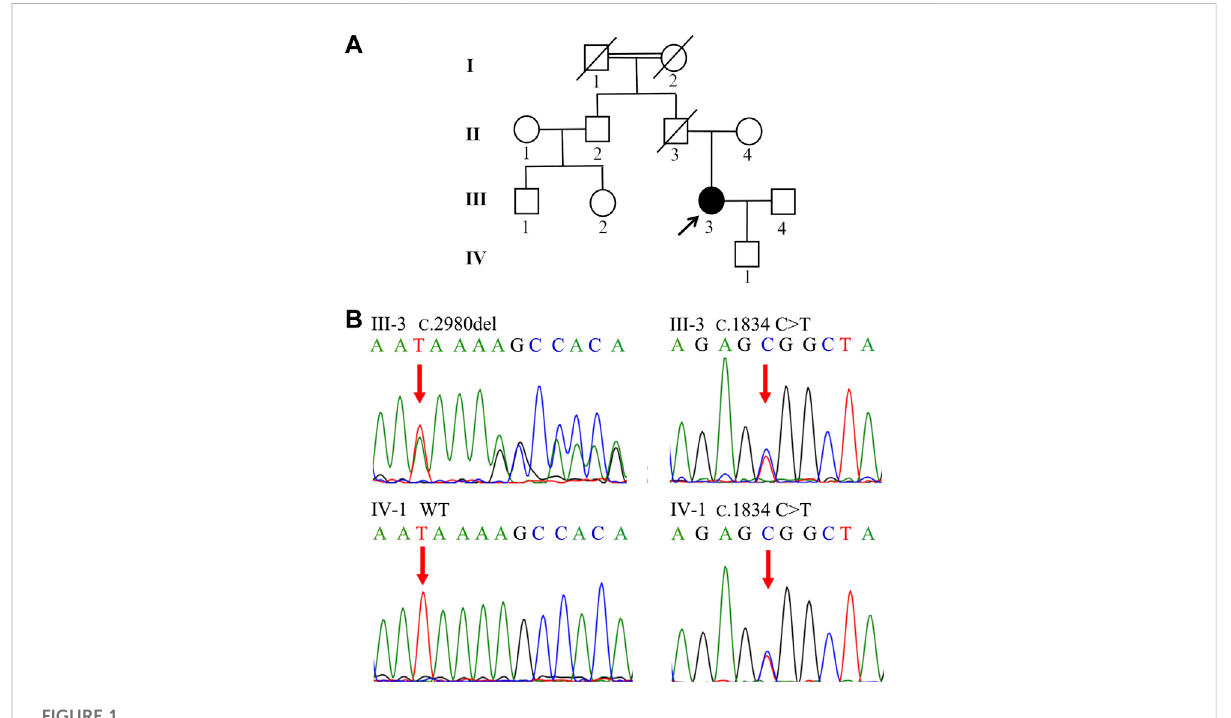
FIGURE 1 Family tree and genetic analysis of Family 1. (A) Proband III-3 was diagnosed with DJS. (B) Sanger sequencing revealed a compound heterozygous (c.2980delA and c.1834 C > T) ABCC2 mutation in III-3. IV-1 shared the heterozygous c.1834 C > T